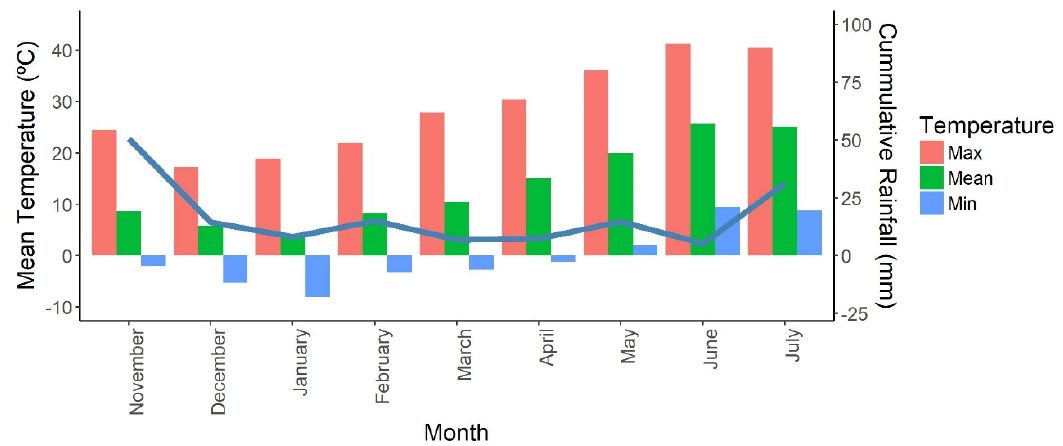
Figure 1. Cumulative monthly rainfall (blue line) and maximum, minimum, and mean temperature (bars) in Colmenar de Oreja for the 2016–2017 crop cycle.